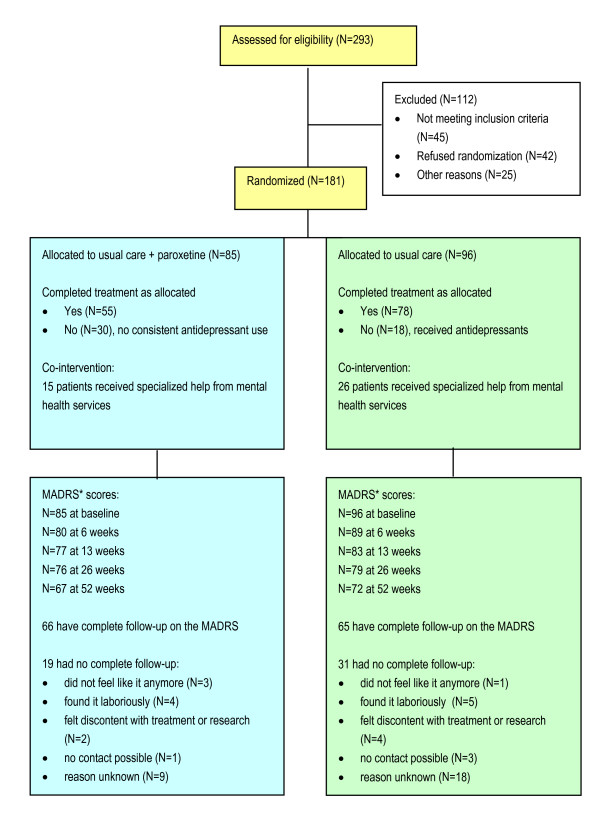
Flow chart of patients through trial. MADRS, Montgomery Åsberg Depression Rating Scale.